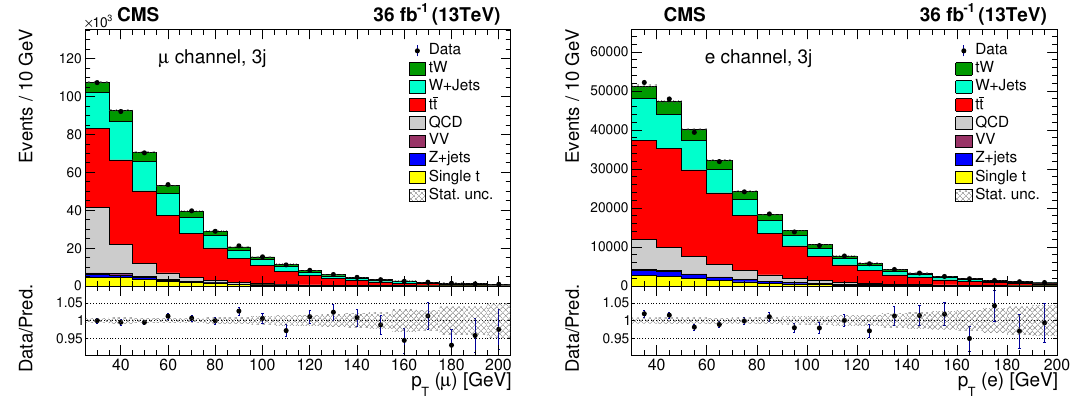
of the selected muon (left) and electron (right) in the signal region of their Figure 3 . The p T respective channels. The signal and backgrounds have been scaled with the results of the final fit. The lower panel shows the ratio of observed data to the prediction for signal and background. In both panels the hatched regions show the statistical uncertainty from the limited size of the simulated samples for each